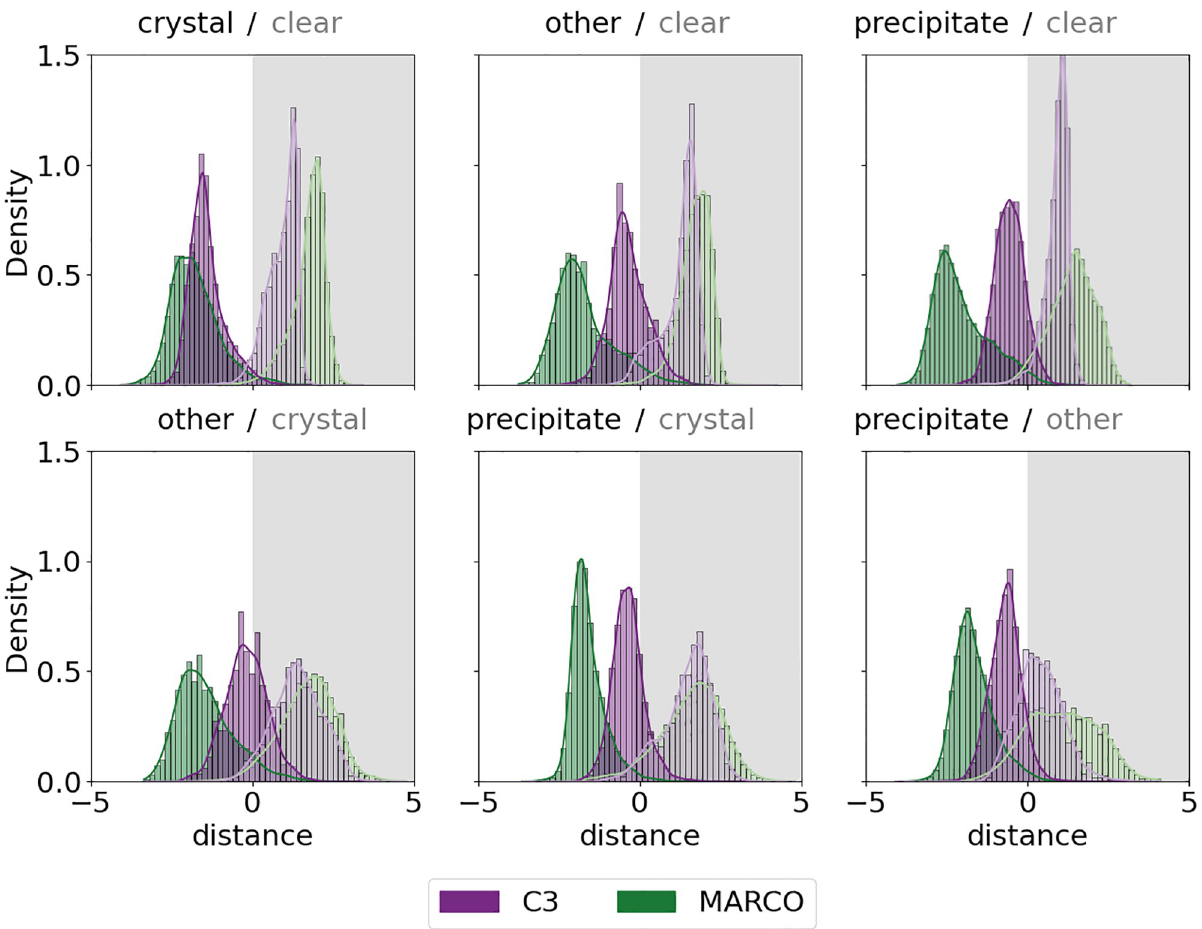
Fig 8. Histograms of distances of images from the decision boundaries. Images from the C3 test set are shown in purple, and those from the MARCO validation set are shown in green. The four classes give 6 decision boundaries, which are shown as clear/grey boxes. The C3 images are closer to the decision boundaries as defined by the MARCO training set, and are are not symmetric around the decision boundaries.